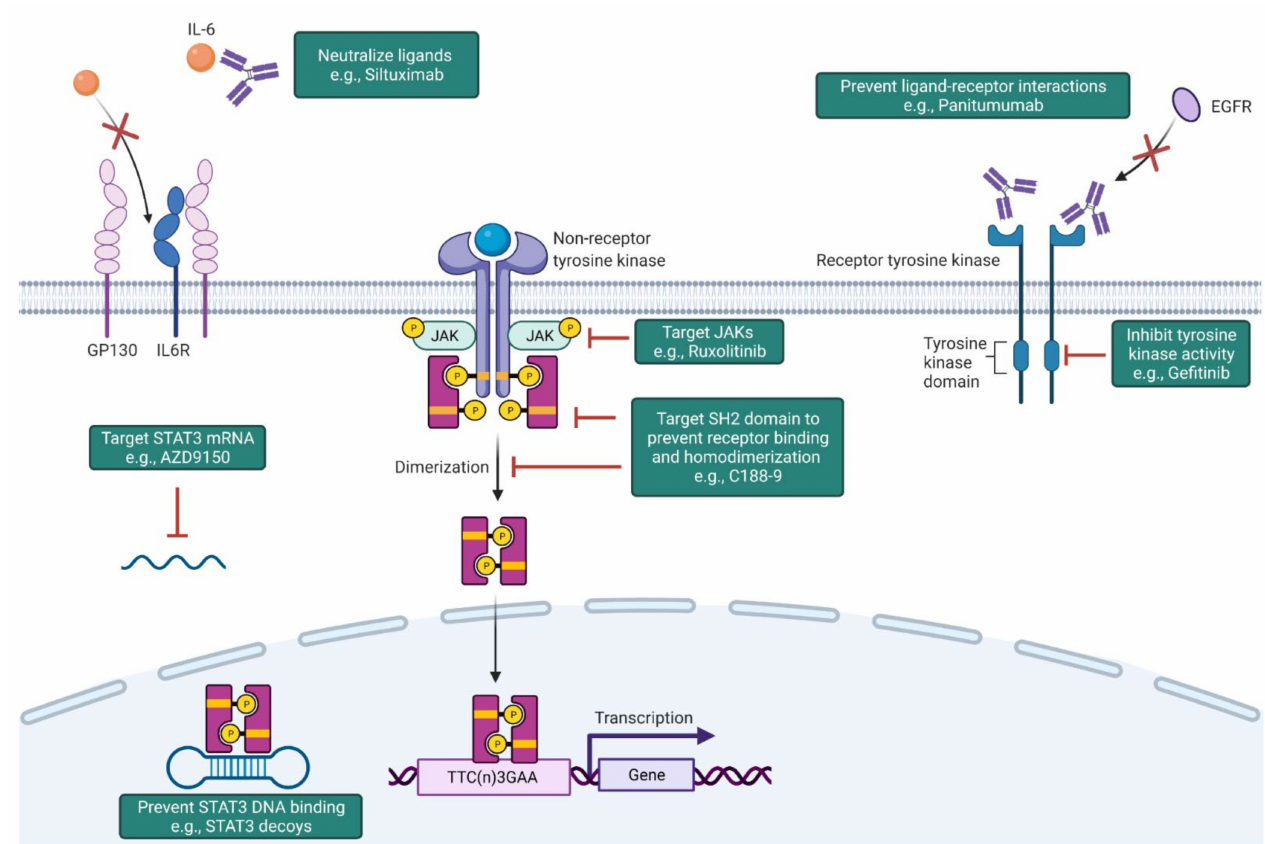
Figure 4. Strategies to inhibit STAT3 activation. Strategies to inhibit STAT3 signaling include preventing receptor/ligand interactions, inhibiting tyrosine kinase activity, targeting the SH2 domain of STAT3 to interfere with receptor binding and/or homodimerization, promoting the degradation of STAT3 mRNA, and blocking the binding of STAT3 to DNA. Figure created in